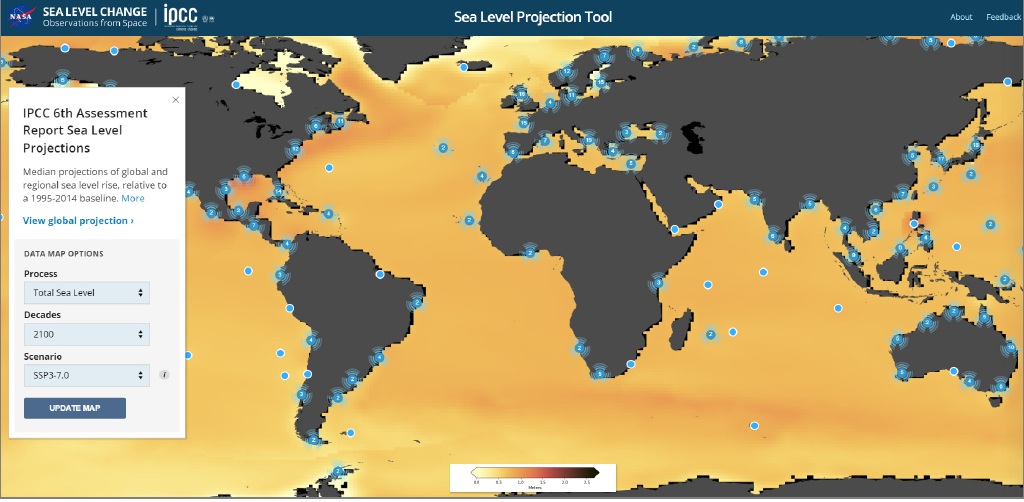
Figure A3. Overview of the resource. Source: NASA (2021).